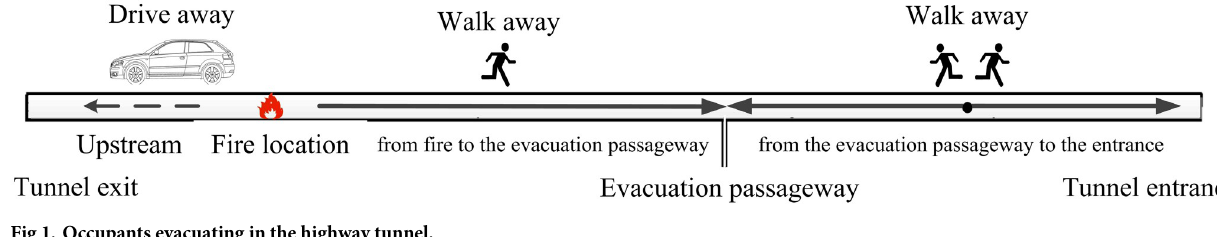
Fig 1. Occupants evacuating in the highway tunnel.